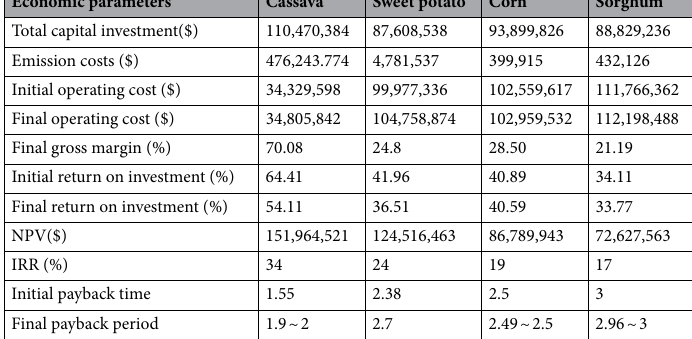
Table 12. Economic parameters